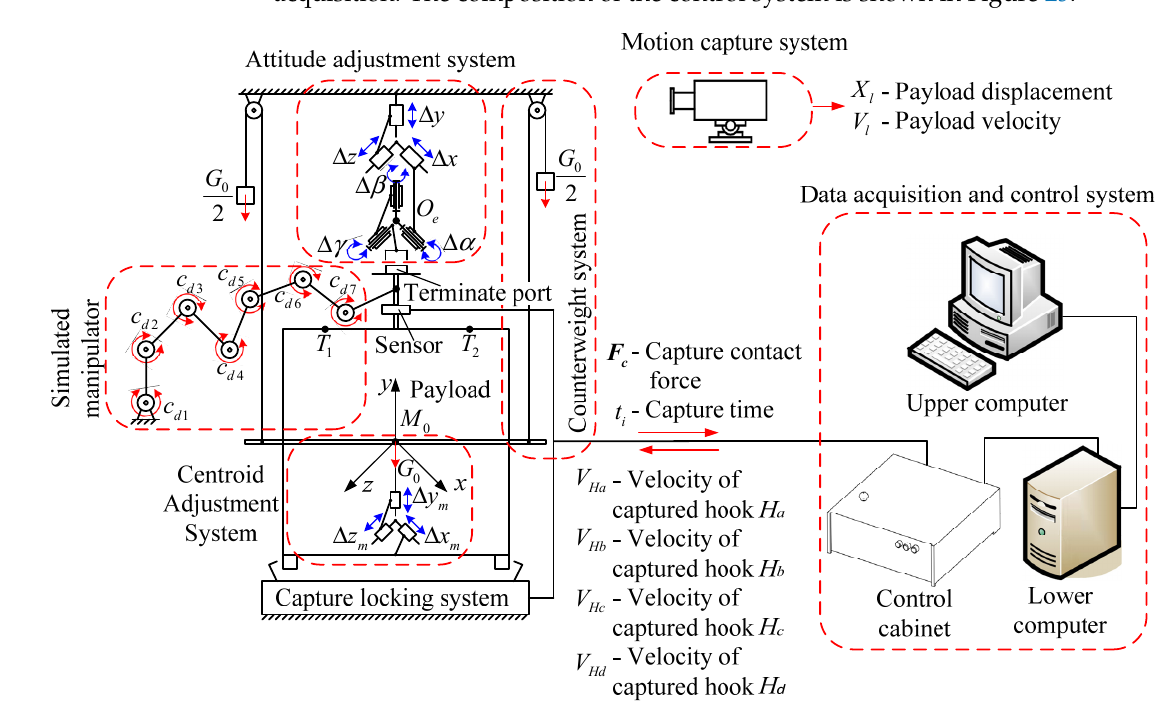
Figure 25. Schematic diagram of the space payload ground capture test system.